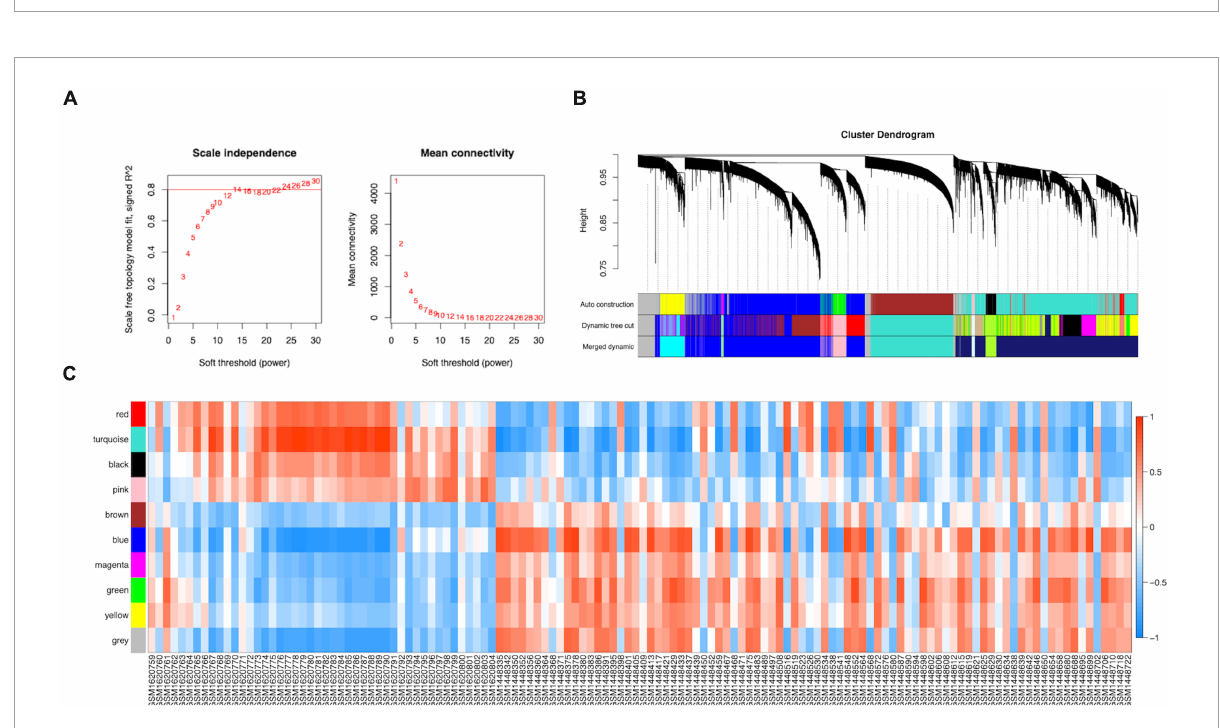
FIGURE3 Construction of the co-expression network. (A) A scale-free co-expression network estimated by the soft-thresholding powers. (B) Ten co-expression modules constructed by clustering dendrograms of all DEGs based on topological overlap and assigned in different module colors (non-clustering DEGs shown in gray). (C) The relationships between modules and clinical